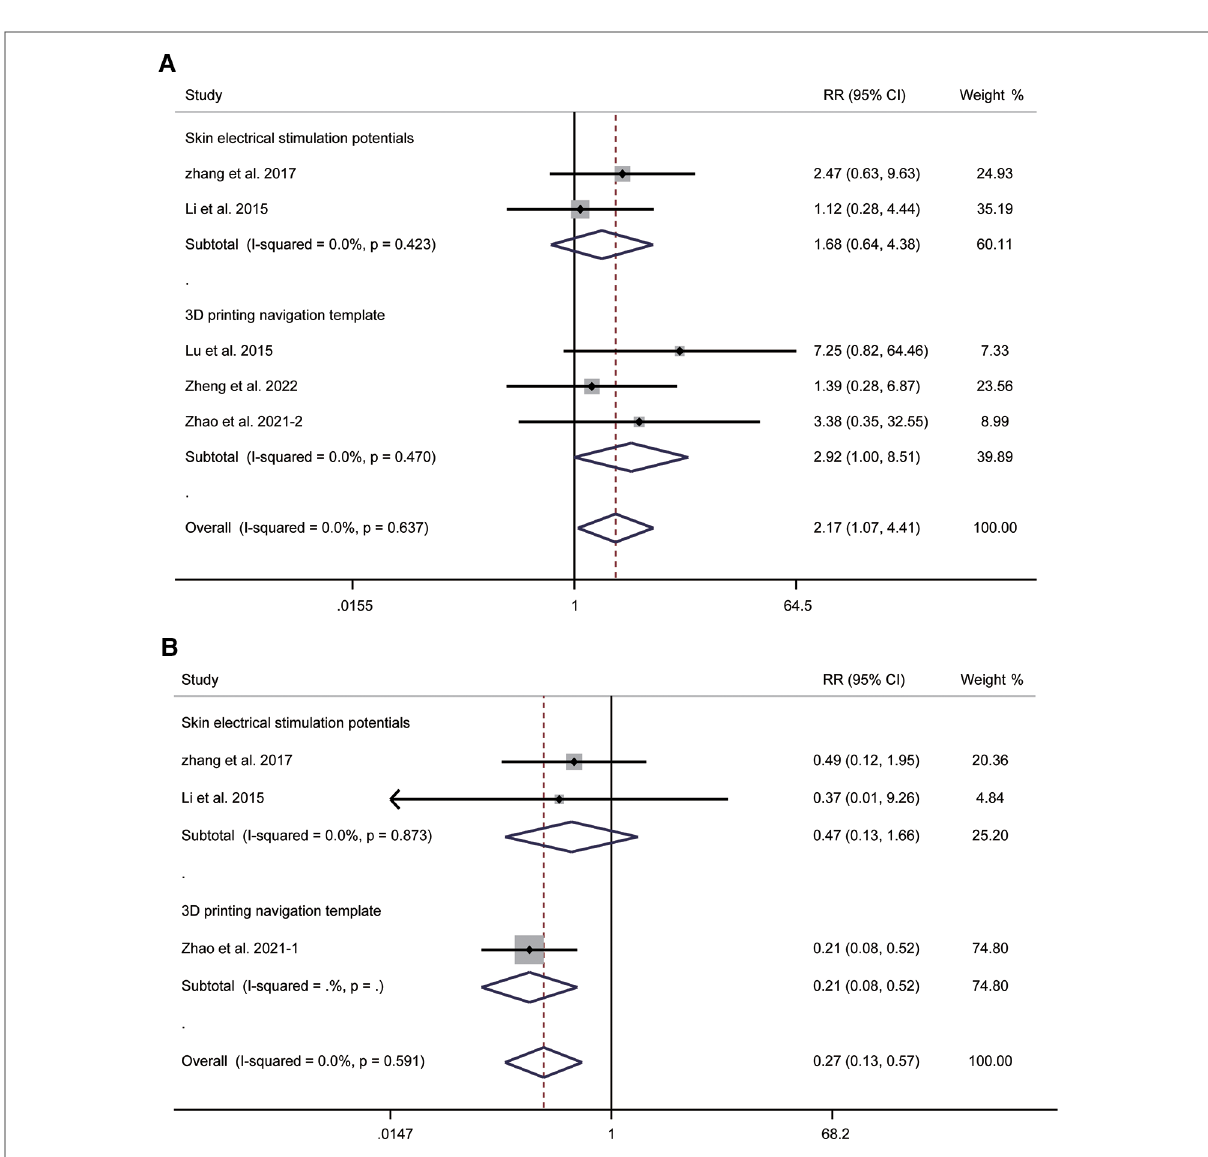
FIGURE 7 Forest plot of ef fi cacy ( A ) and recurrence rate ( B ) for the comparison of different guidance techniques (combined with other guidance techniques vs. simple image